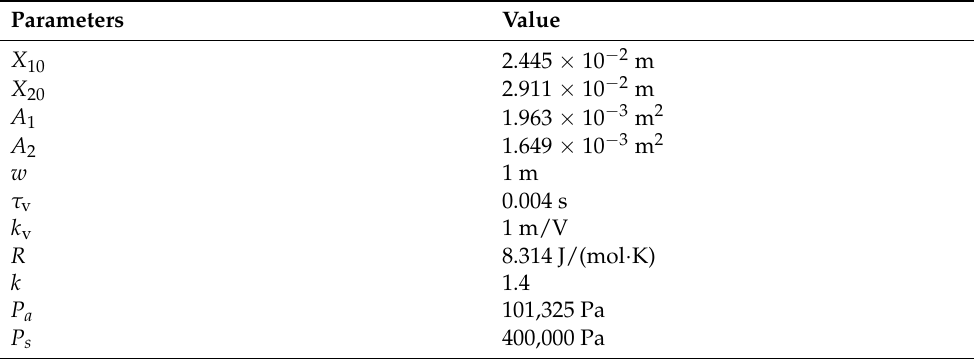
Table A1. Cylinder and electro-pneumatic regulator